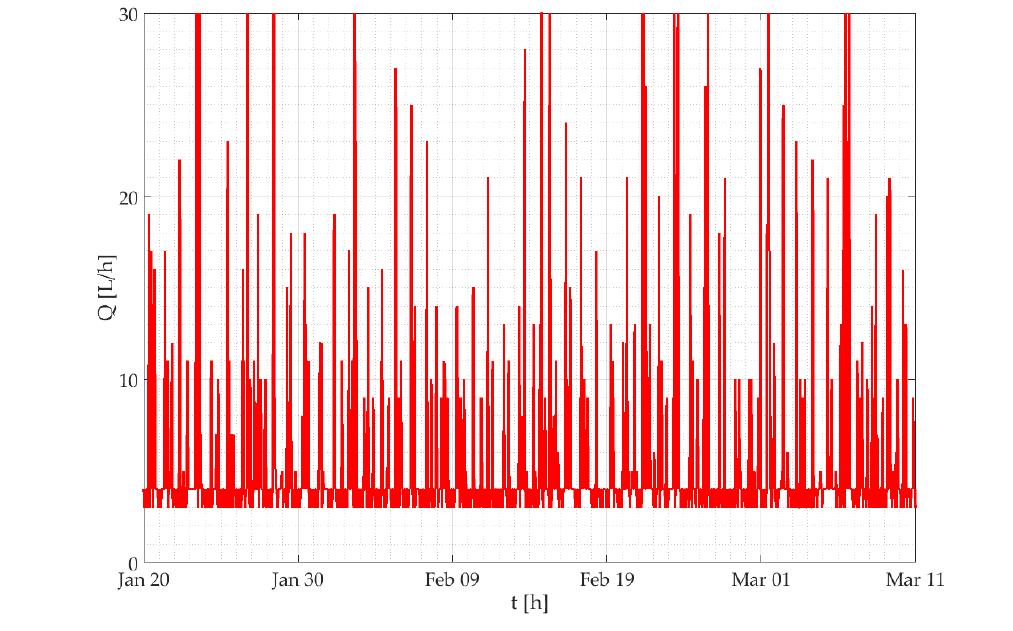
Figure 9. Hourly incremental consumption trends of a user affected by a small